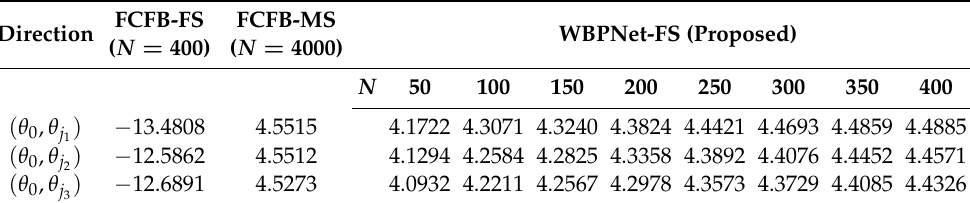
Table 2. The output SINR (dB) under different snapshots N for comparison. FCFB-FS Direction